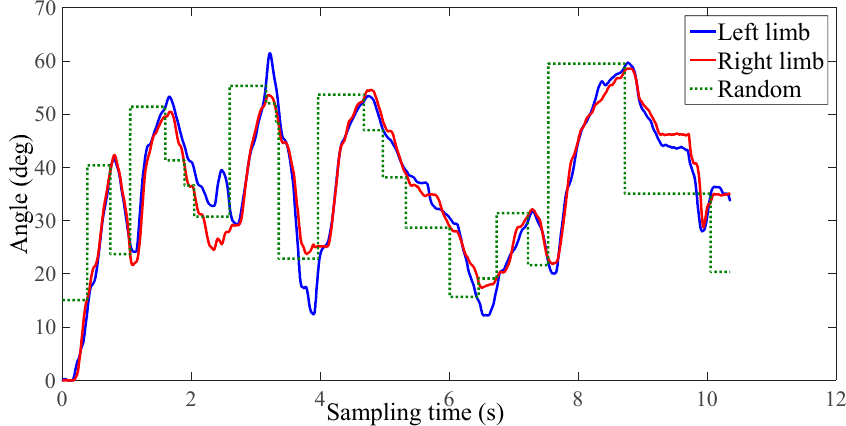
Figure 12. No tactile feedback (the third group, subject one).